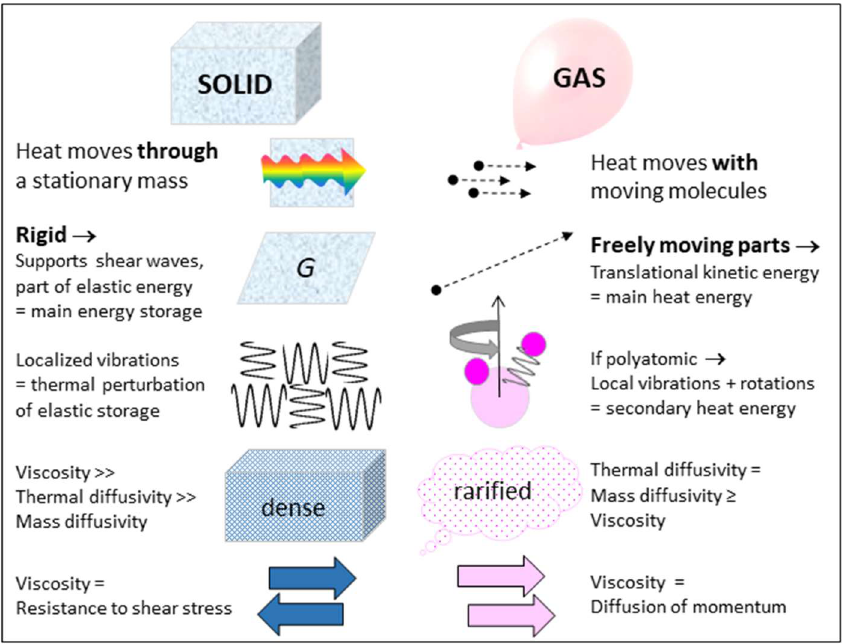
Figure 1. Summary and comparison of the characteristics of solids and gases most relevant to heat and its flow. The shear modulus, G , describes a special type of stored energy in solids, which is part of the elastic energy, the main reservoir. Atoms are shown as balls, with dotted arrows indicating direction of long-distance motions. Sine waves without arrowheads indicate local, back-and-forth, microscopic